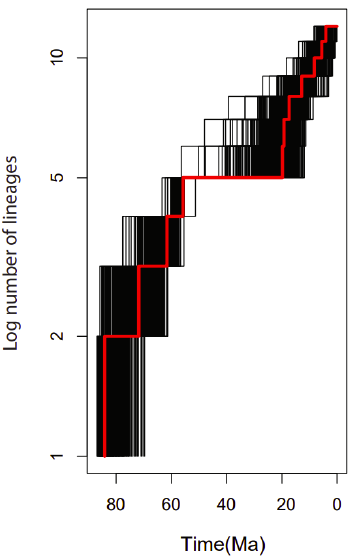
Figure 10. Lineage-through-time (LTT) plots and the rate shifts in the 15 genera used in the family Rutaceae. Black lines represent the LTT plots for 1000 trees randomly selected from the BEAST analysis. The red line shows the plot from the maximum clade credibility tree.